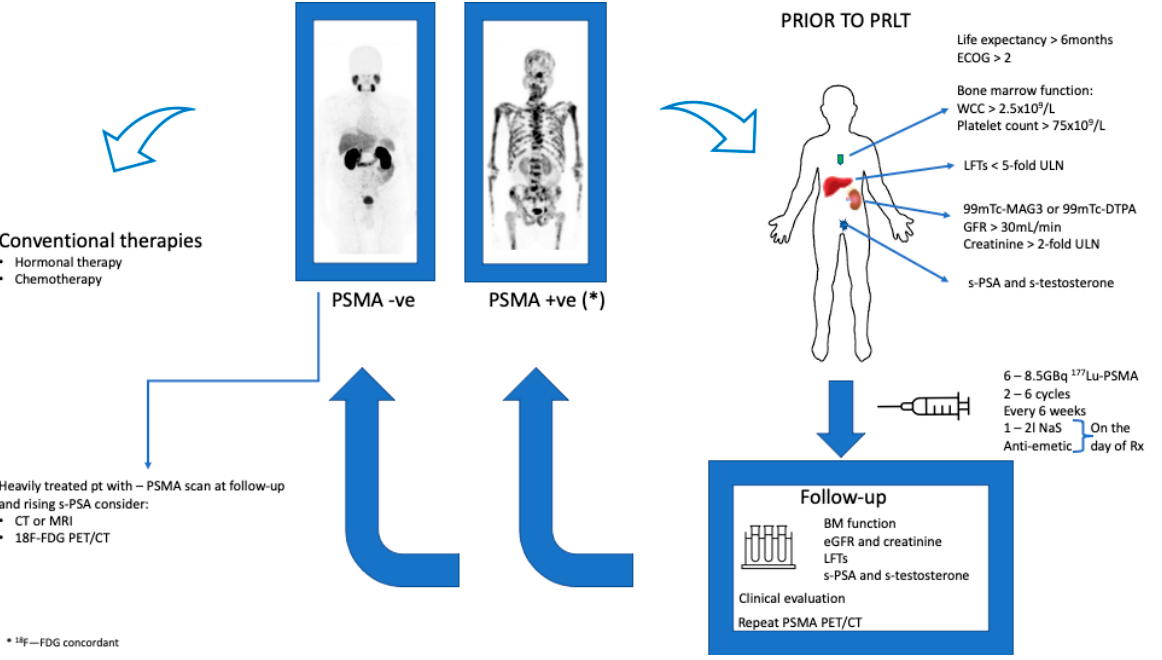
Figure 2. Algorithm of the practical aspects of therapy from the selection of patients for targeted radionuclide therapy to the therapeutic procedure and follow-up. * 18 F—FDG Concordant disease.